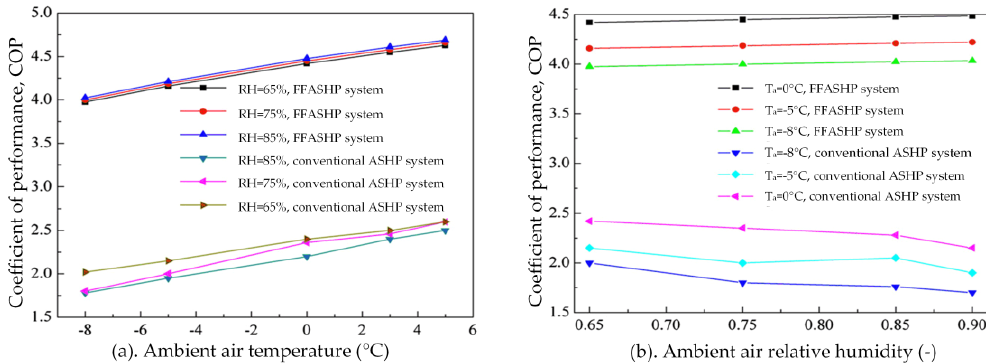
Figure 24. Effects of ambient air temperature and RH on the COP of FFASHP and conventional ASHP [53].